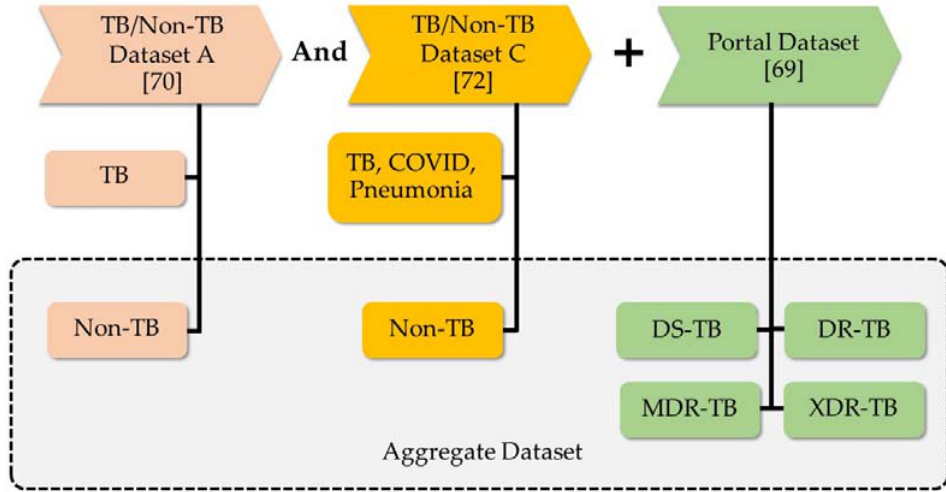
Figure 5. Framework of the TB/non-TB and Drug-Resistant dataset. Table 12. Details of the compared method in existing